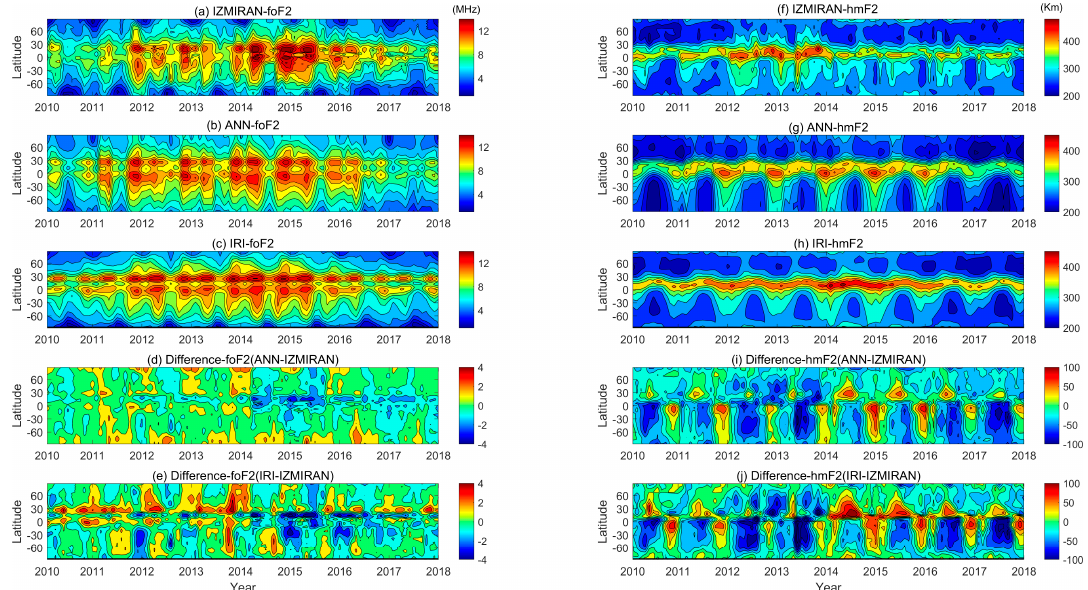
Figure 8. Comparative results of foF2 and hmF2 from the Pushkov Institute of Terrestrial Magnetism, Ionosphere and Radiowave Propagation of the Russian Academy of Sciences (IZMIRAN), ANN and IRI along the Greenwich meridian during 2010–2017. In Figure 8, the left and right columns indicate the comparative results of foF2 and hmF2, respectively. The panels in the left column indicate that both simulated maps of ANN and IRI agree well with the reference maps. During 2010–2017, the maximum value of ionospheric foF2 along the Greenwich meridian increased from 10 MHz (2010) to 14 MHz (2015). After that, the maximum value gradually decreased to 6–10 MHz, which was associated with the intensity of solar radiation.